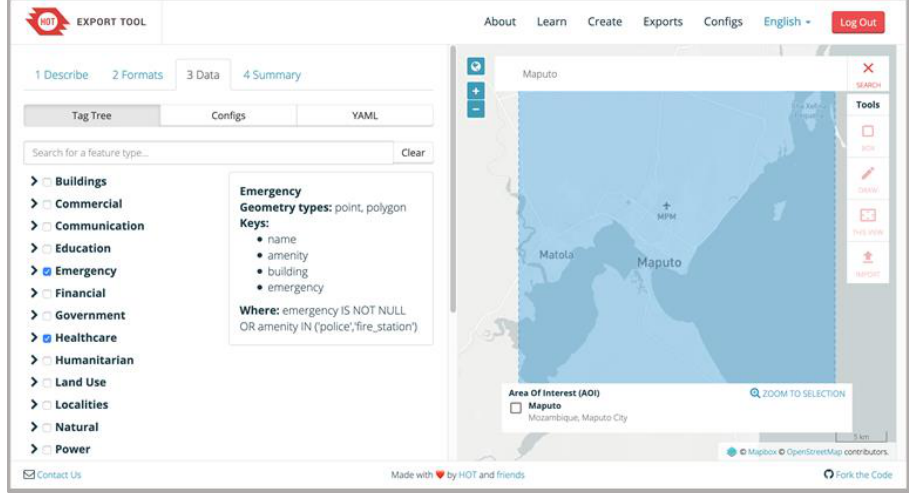
Figure 6. Example from a practical activity to obtain thematic geodata via HOT Export Tool